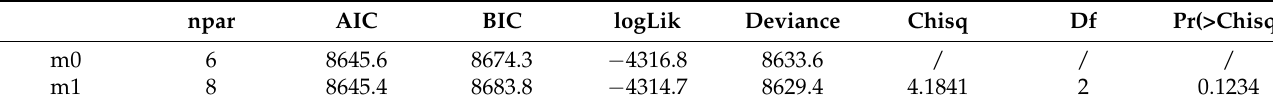
Table A2. Effect of treatment on the growth rate in plant height.